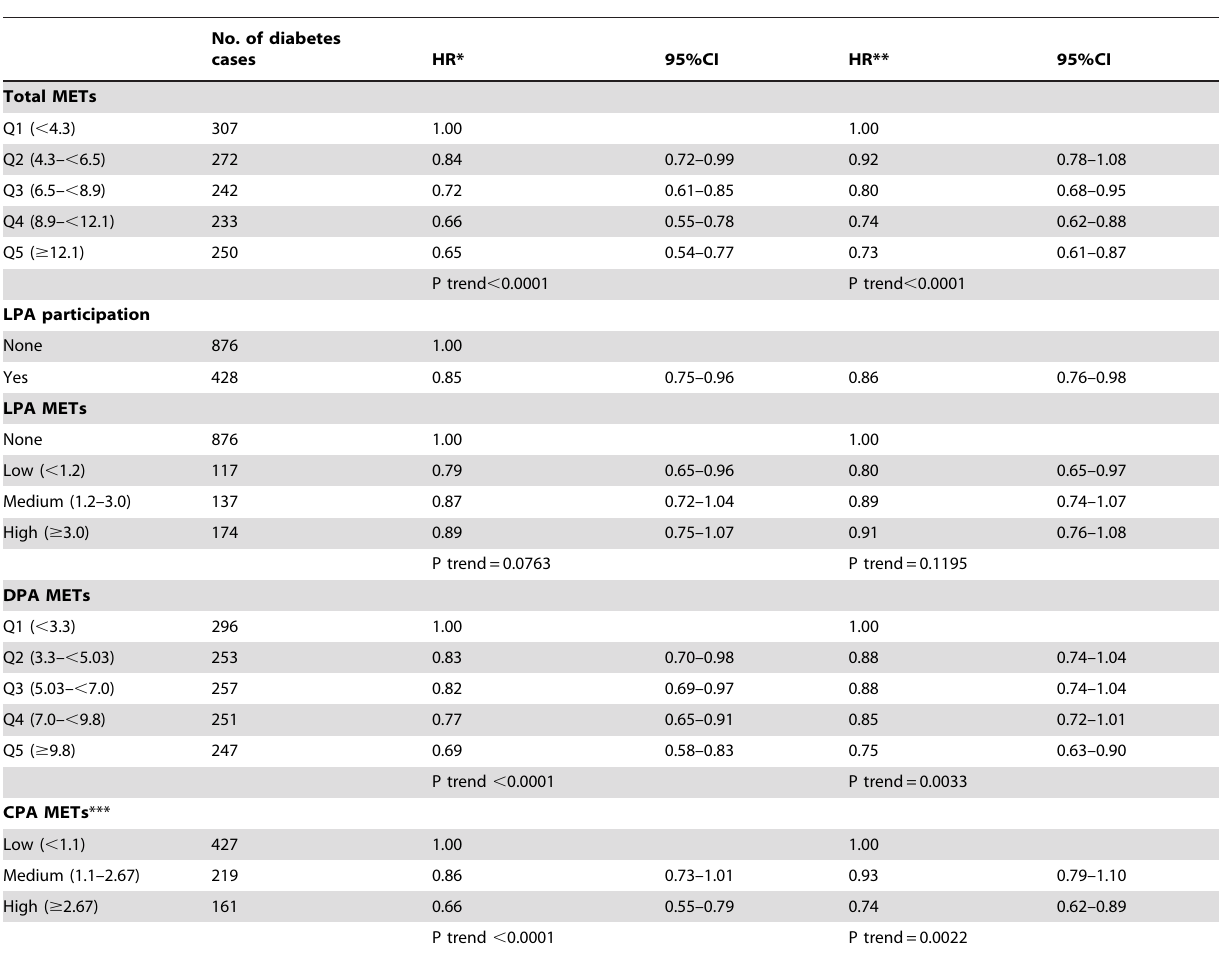
Table 2. Associations between types of physical activity and T2DM